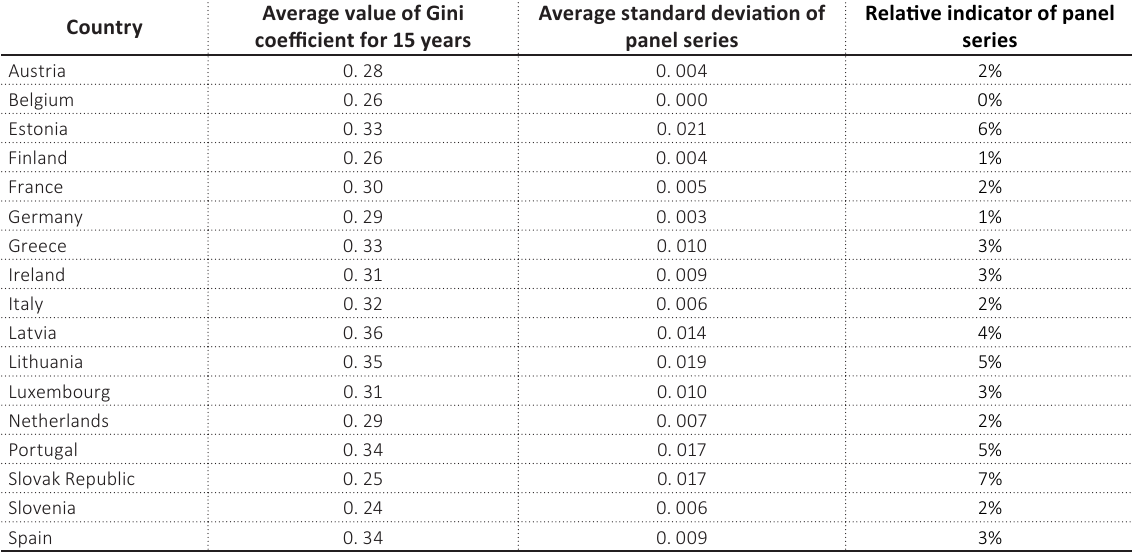
Table 2. Evaluation of the stability of the panel series of the Gini coefficient data for 2005–2019